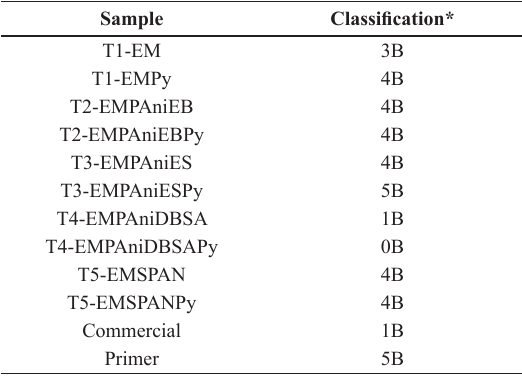
Table 3. Adhesion test classification of the coatings.